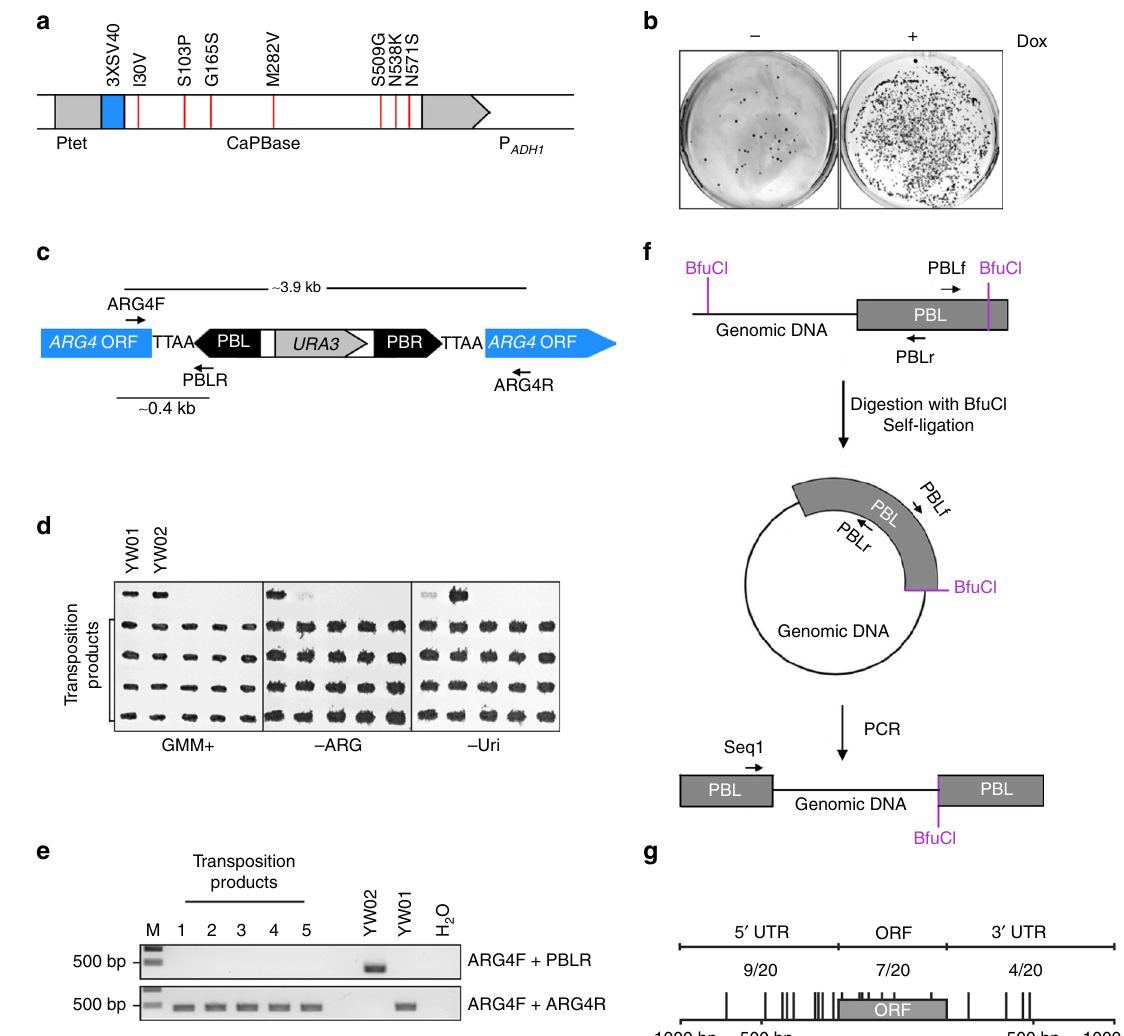
Fig. 1 PB transposition in haploid C. albicans . a Schematic description of the CaPBase construct inserted at the ADH1 locus. Ptet, Tet-On promoter; 3XSV40, SV40 nuclear localization signal; and P ADH1 , ADH1 promoter. Hyperactive mutations are indicated along the top. b Selection of transformants with PB [URA3] integration on plates. YW01 cells were grown in YPD for 48 h in the presence ( + ) or absence ( − ) of Dox before transformation with pPB[URA3]. Transformation products were spread onto GMM plates (90 mm Petri dishes). c Schematic description of the PB[URA3] cassette integrated within ARG4 . Arrows indicate the PCR primers used to detect PB excision. d Con fi rmation of the auxotrophic phenotypes of transposition products of YW02. Strains grown on a GMM + Uri + Arg + His (GMM + ) plate were replica-transferred onto a GMM + Uri + His (-Arg) or GMM + Arg + His (-Uri) plate and then incubated at 30 °C overnight. YW01 and YW02 were included as controls. e Precise excision of PB from the ARG4 locus. Representative gel electrophoresis results of PCR products ampli fi ed from YW02 transposition products using primers shown in c . f Schematic description of the identi fi cation of PB insertion sites by inverse PCR. Arrows indicate the PCR (PBLf and PBLr) and sequencing (Seq1) primers used. g Distribution of PB insertion sites in and around ORFs in YW02 transposition products. Positions in the ORF were determined by treating the entire length of an ORF as 100 and then determining the relative position of an insertion in the ORF. Positions in the 5 ′ or 3 ′ region were determined by whether the insertion was closest to the 5 ′ or 3 ′ end of an